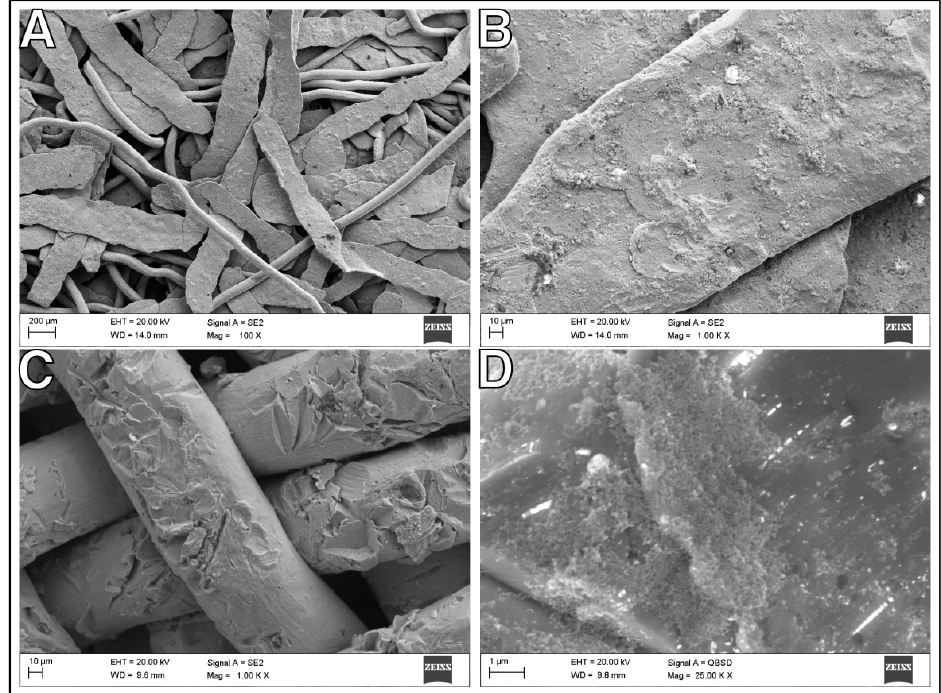
Figure 3. Scanning electron microscopy (SEM) images for nanometal/Ni-mesh catalysts, ( A ) Ni-mesh support fibers with Ru nanoparticles, ( B ) Re nanoparticles on the fibers surface, ( C ) Pd nanoparticles on the fiber surface, ( D ) Au nanoparticles on the surface of the fibers in contact. Table 1. Specific surface area (SSA) for the tested supports.